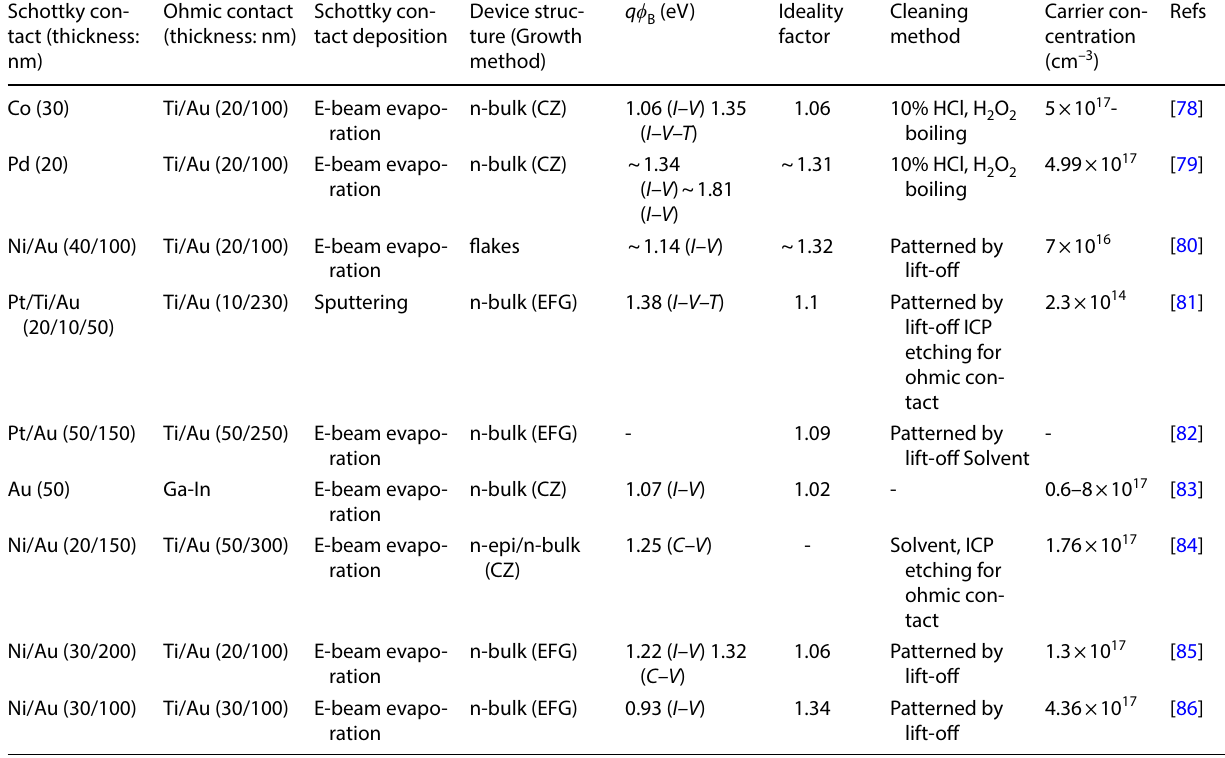
a Carrier concentration for the layer on which the Schottky contacts are formed), b Growth method: Czochralski (CZ), Edge-defined film-fed